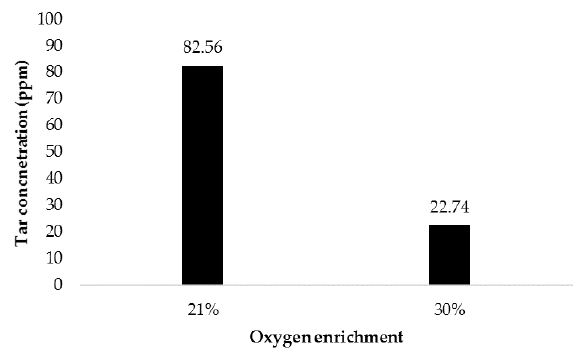
Figure 9. CST tar analysis results.